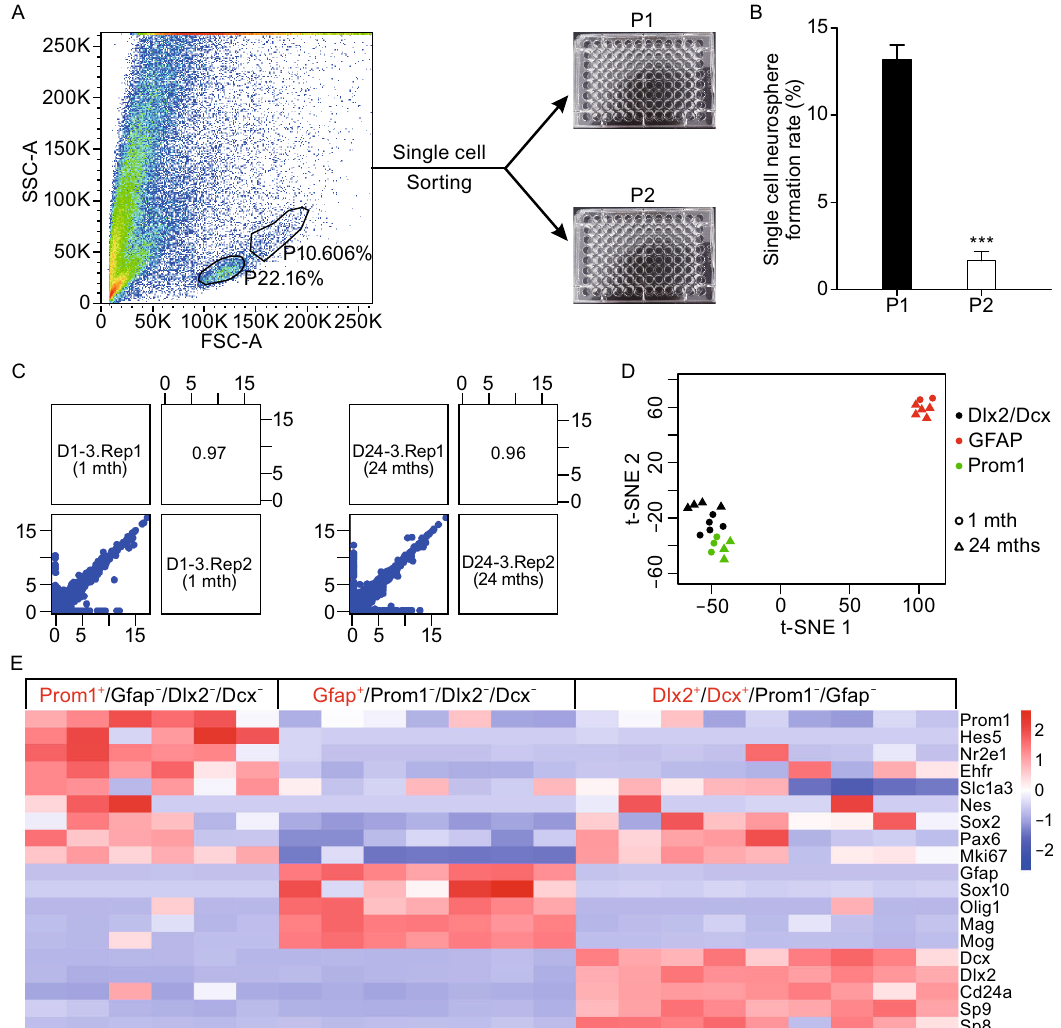
Figure 4. Transcriptome analysis of single cells derived from a discrete SEZ/SVZ population of cells. (A) P1population rather than P2 was identi fi ed as enriched by NPCs, by fl ow cytometry and single cell neurosphere formation analysis was performed. (B) Quanti fi cation of single cell neurosphere formation rate in P1 and P2 populations. At least three independent experiments were quanti fi ed (*** P < 0.001, n ≥ 3). (C) cDNA samples from two single cells were subjected to two independent library construction